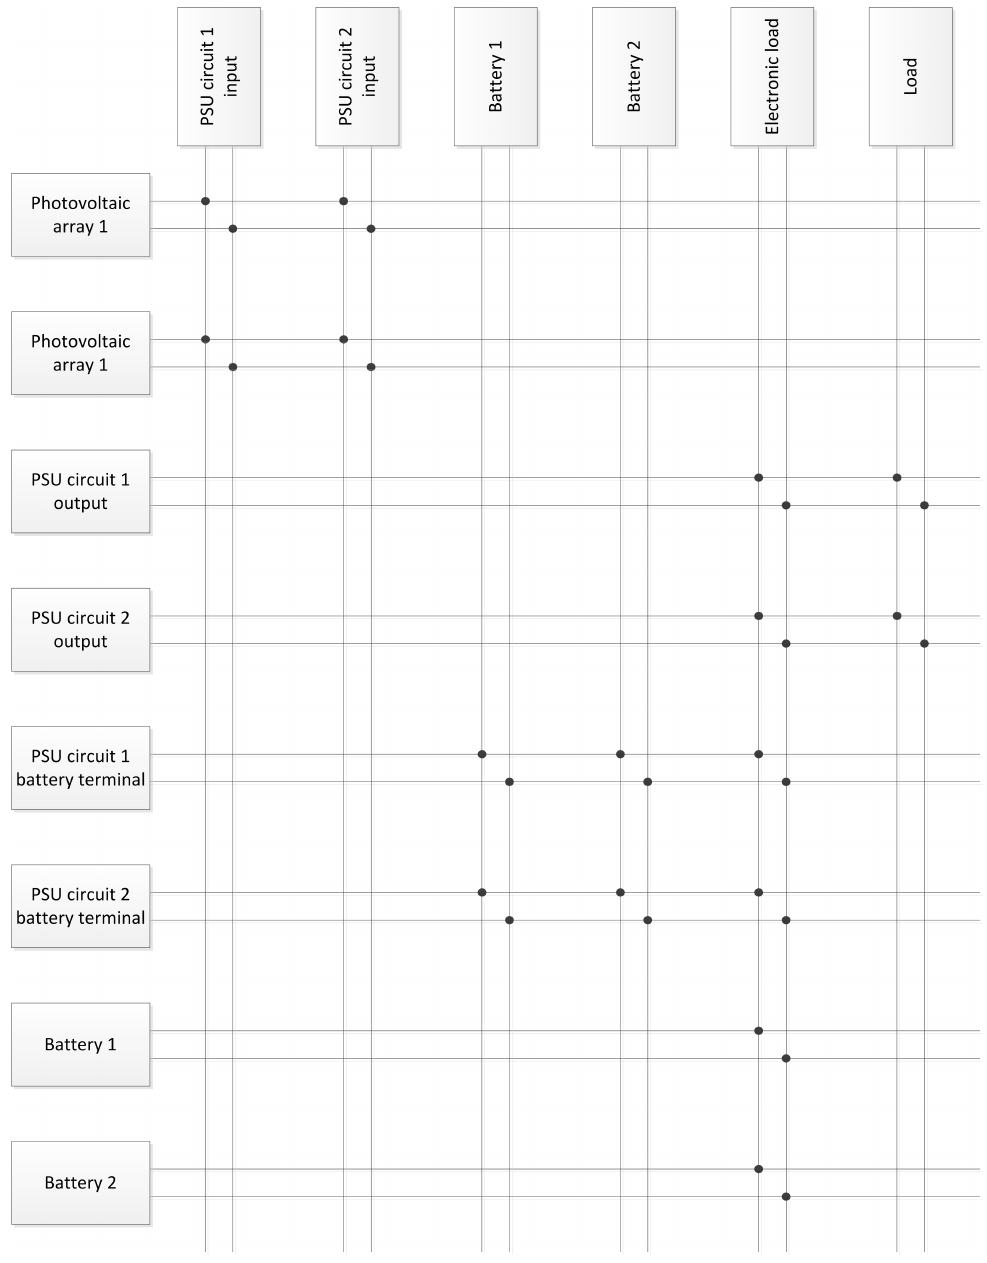
Figure 4. Switching matrix